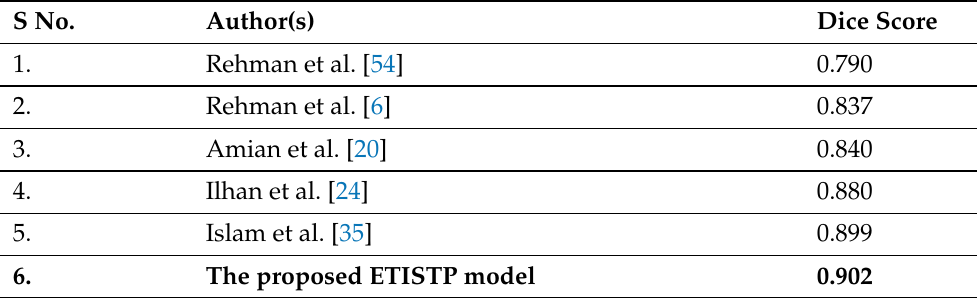
Table 11. Tumor identification results with respect to the Brats2020